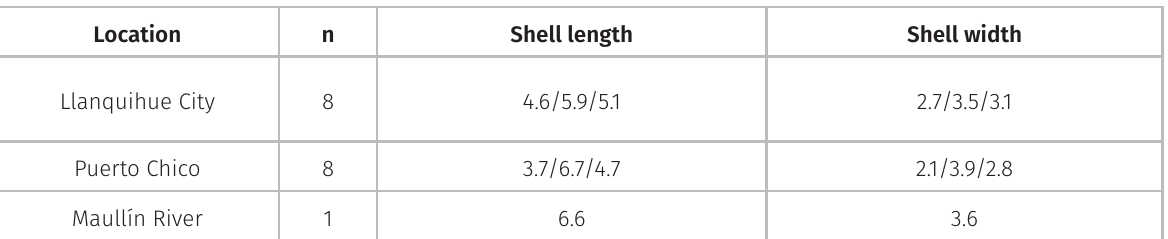
Table I. Shell dimensions in mm (minimum, maximum and mean values) of largest specimens of Physa acuta sampled in Llanquihue